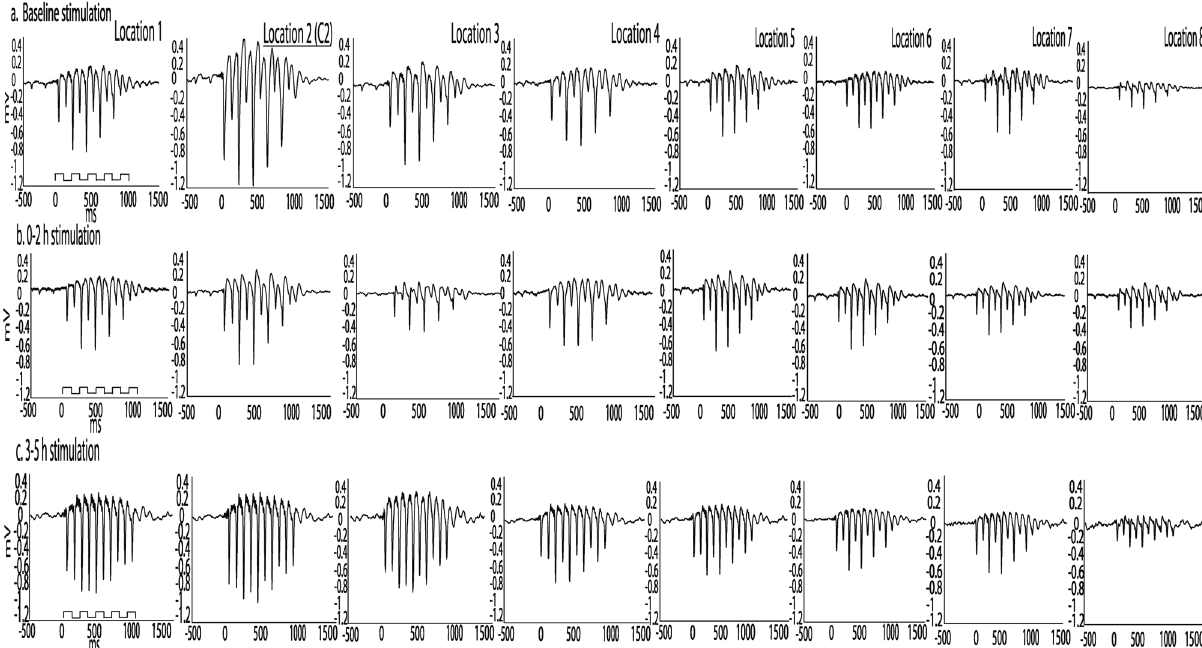
Figure 2. Evoked LFP spread following whisker C2 stimulation was noticeable across all electrodes regardless of when sensory stimulation was delivered. Representative LFP horizontal spread during ( a ) baseline, + 0 h ( b ) and, + 3 h stimulation ( c ) in layer 4 recordings. The step function (left column) represents the 5 pulse 5 Hz train of stimulation delivered for each trial. Evoked LFP averaged across trials for a representative animal are shown for each of 8 horizontal, cortical recording locations. ( a ) and ( b ) represent evoked LFP from different animals each of which underwent 2 h of sensory stimulation delivered at distinct post-pMCAO time points. Evoked LFP decays over distance from peak recording location [underlined location 2 (C2)] but is still present at recording location 8 (3.9 mm from C2 functional stimulation was delivered after pMCAo ( H = 0.51, p = 0.78, Kruskal–Wallis test). Consistent with the decay of LFP magnitude over distance from the peak recording location, the latency to LFP negative peak magnitude increased at recording locations further from the peak in all stimulation conditions (latency to negative peak magnitude in furthest electrode, at baseline stimulation 22 ms ± 2.14, at 0–2 h stimulation 22 ± 1.72, and at 3–5 h stimulation 23.16 ± 0.77). No significant difference in latency to negative peak magnitude was observed between baseline, 0–2 h, and 3–5 h stimulation ( H = 0.85, p = 0.32, Kruskal–Wallis test). In 3–5 h stimulation, the LFP positive peak magnitude continued to be distinctly robust and its spread significantly increased from baseline stimulation at the furthest electrode away from the peak recording location ( H = 7.02, p = 0.03, Kruskal–Wallis test, % of LFP positive peak magnitude 3.9 mm away from peak recording location (100%), at baseline stimula- tion 35.04% ± 2.71, at 0–2 h stimulation 40.70% ± 1.86, and at 3–5 h stimulation 61.92% ± 1.74). A single whisker deflection also evoked large-scale LFP spread in cortical layers 2–3, 5A, and 5B both before and after pMCAo (Supplemental Figure 1). Spatiotemporal synchrony of spontaneous LFP increased within minutes after pMCAo and remained high during the acute post pMCAo period. In animals with no sensory stimulation deliv- ered after pMCAo ( n = 7), spontaneous LFP became highly synchronous across different recording locations directly after pMCAo (Figs. 3 and 4). To quantify the synchrony observed in post pMCAo spontaneous LFP, we cross-correlated each electrode with all others in the electrode array for each 1 s LFP trace before and after pMCAo while allowing for a time lag of up to 100 ms. Each representative cross-correlogram depicted in Fig. 4a was derived from consecutive, non-overlapping 1 s LFP traces. Corresponding time lags from each of these consecutive cross-correlograms are shown in Fig. 4b in which the color bar indicates either the full range of pos- sible time lags (± 100 ms) (Fig. 4b bottom panel) or a zoomed in range of time lags (± 6 ms) (Fig. 4b top panel). The lower triangular matrix in each of Fig. 4a’s cross-correlograms illustrates the extensive range of r 2 values resulting from comparing baseline electrode pairs. Conversely, the upper triangular matrix of each of Fig. 4a’s cross-correlograms shows that post pMCAo electrode pairs were highly correlated regardless of the spatial loca- tions compared. The corresponding time lags represented in Fig. 4a depict the leading or lagging electrode in each pair and the associated time lag for every (1 s) cross-correlated. Within 1 min after occlusion, the time lags decreased in range (representative case, post pMCAo time IQR decreases 64.3% from baseline, Fig. 5a right; group statistics, pMCAo, n = 7, post pMCAo time IQR decreases 45% from baseline, Fig. 5b right) while r 2 values increased (Figs. 4a and 5a,b, left).